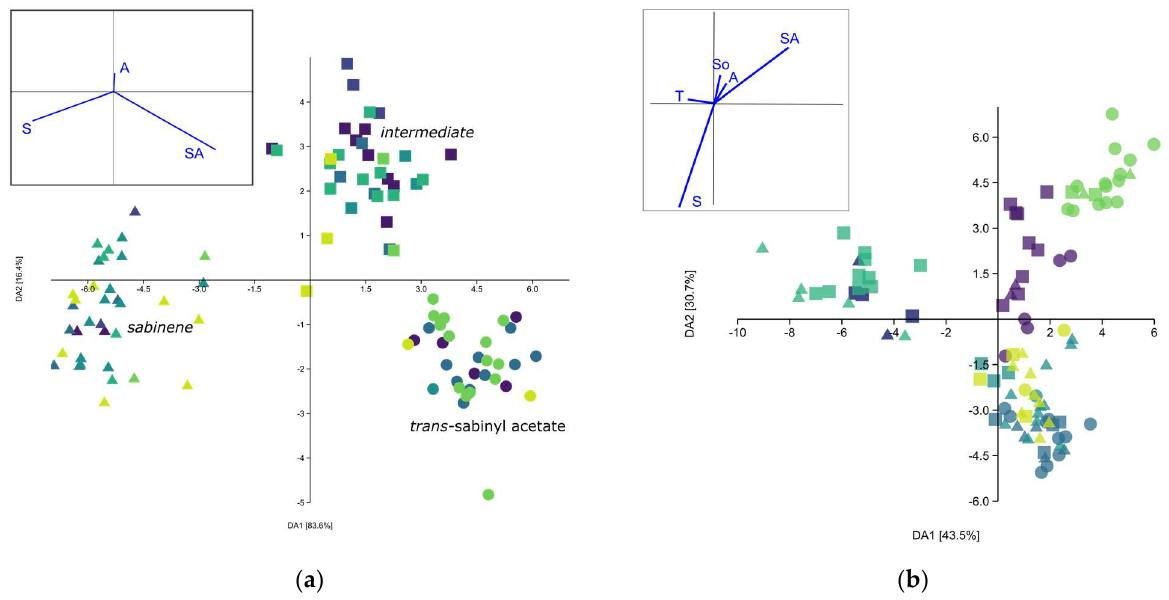
Figure 3. Discriminant analysis scatter plot of leaf essential oil composition of Juniperus sabina var. balkanensis; ( a ) putative chemotypes as groups; symbols correspond to different chemotypes, while dots with same colour belong to same population; ( b ) populations as groups. Figure 5. ( a ) PCoA scatter plot (Jaccard’s distances), − Central Balkan, − Resava gorge, − Figure 5. ( a ) PCoA scatter plot (Jaccard’s distances), − Central Balkan, − Resava gorge, − Figure 5. ( a ) PCoA scatter plot (Jaccard’s distances), − Central Balkan, − Resava gorge, − Figure 5. ( a ) PCoA scatter plot (Jaccard’s distances), − Central Balkan, − Resava gorge, − Figure 5. ( a ) PCoA scatter plot (Jaccard’s distances), − Central Balkan, − Resava gorge, − Mt. Bistra, − Mt. Korab, − Mt. Prokletije, − Mt. Biokovo, − Mt. Velebit; triangles − sab- Mt. Bistra, − Mt. Korab, − Mt. Prokletije, − Mt. Biokovo, − Mt. Velebit; triangles − sab- Mt. Bistra, − Mt. Korab, − Mt. Prokletije, − Mt. Biokovo, − Mt. Velebit; triangles − sab- Figure 5. ( a ) PCoA scatter plot (Jaccard’s distances), − Central Balkan, − Resava gorge, Figure 5. ( a ) PCoA scatter plot (Jaccard’s distances), Mt. Bistra, − Mt. Korab, − Mt. Prokletije, − Mt. Biokovo, − Mt. Velebit; triangles − sab- Mt. Bistra, − Mt. Korab, − Mt. Prokletije, − Mt. Biokovo, − Mt. Velebit; triangles − sab- —Mt. Prokletije, inene chemotype, squares − intermediate chemotype, dots − trans -sabinyl acetate chemotype; ( b ) NJ inene chemotype, squares − intermediate chemotype, dots − trans -sabinyl acetate chemotype; ( b ) NJ inene chemotype, squares − intermediate chemotype, dots − trans -sabinyl acetate chemotype; ( b ) NJ inene chemotype, squares − intermediate chemotype, dots − trans -sabinyl acetate chemotype; ( b ) NJ inene chemotype, squares − intermediate chemotype, dots − trans -sabinyl acetate chemotype; ( b ) NJ tree, Nei’s genetic distances. tree, Nei’s genetic tree, Nei’s genetic distances. tree, Nei’s genetic distances. tree, Nei’s genetic distances.